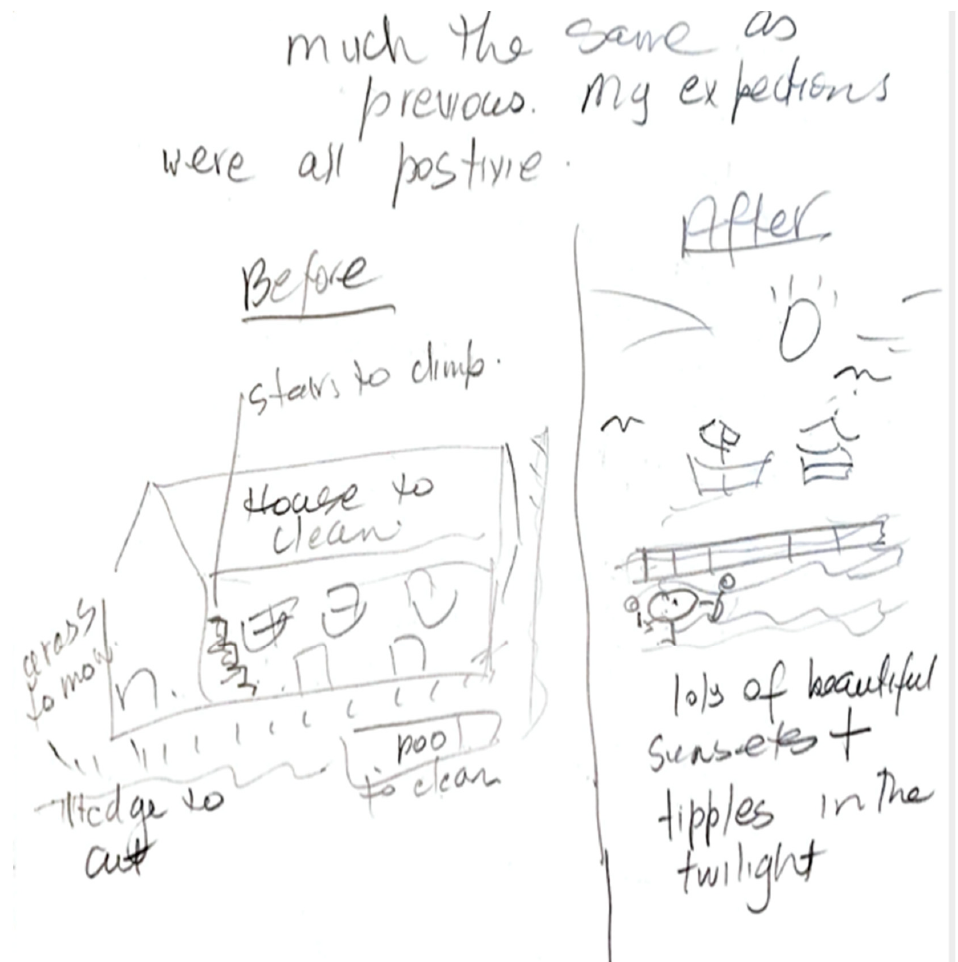
Figure 4. Expecting beautiful sunsets and tipples in the twilight.